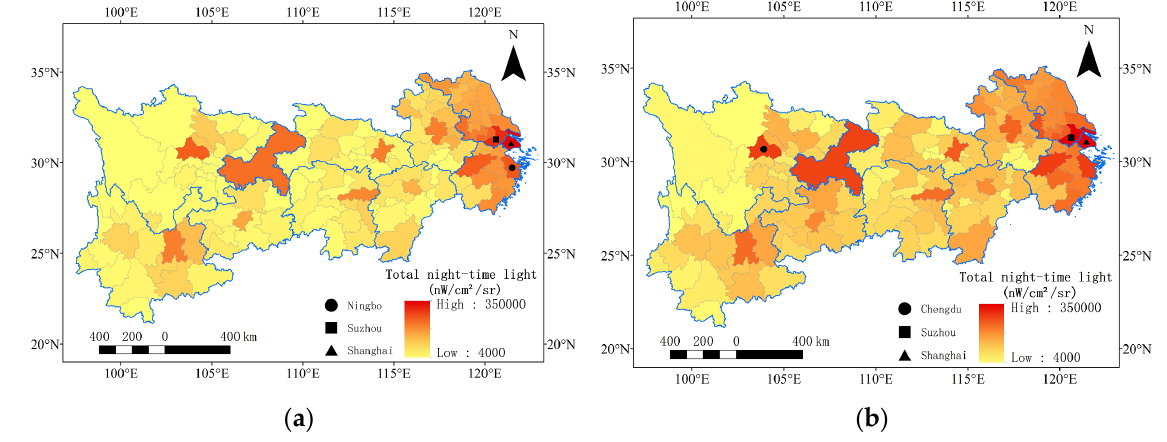
Figure 6. Total night-time light of 130 cities in YREB: ( a ) 2012; ( b ) 2019.